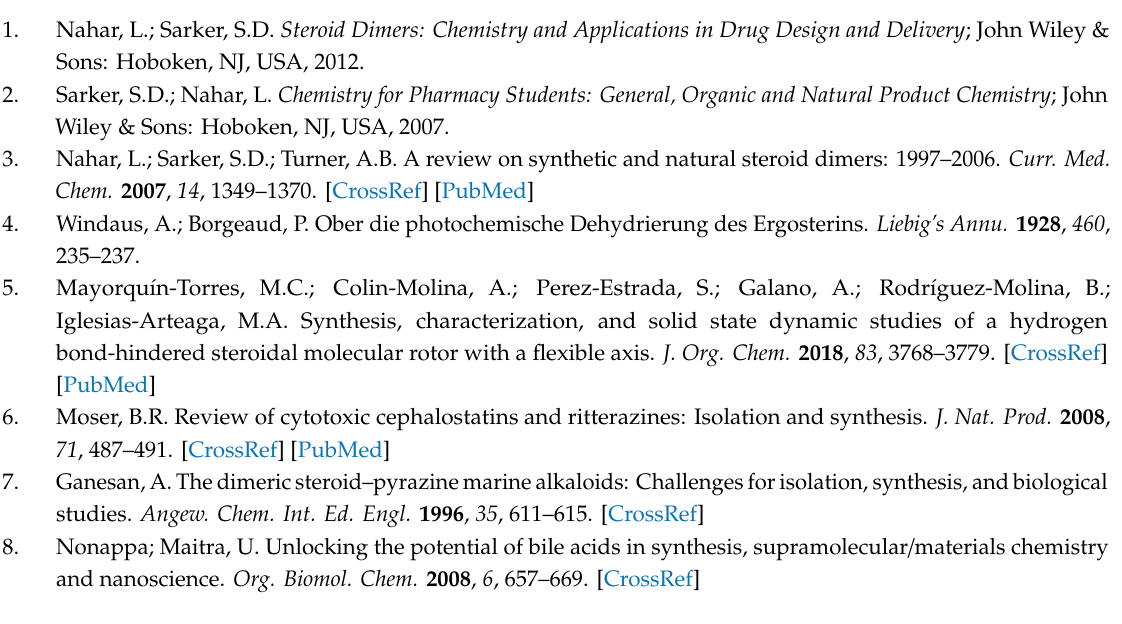
Figure S31: HSQC-NMR spectrum at 500 MHz of Bi-23-acetylhecogenin ester (10b). Figure S32: COSY-NMR spectrum at 500 MHz of Bi-23-acetylhecogenin ester ( 10b ). Figure S33: Di ff erential Scanning Calorimetry analysis of Bi-23-acetylhecogenin ester ( 10b ). Figure S34: Molecular structure with MM2 energy minimization method for 6 and 8c . Figure S35: Bicholesterol ester ( 5 ) in hexane / EtOAc showing membrane-shaped structures (SEM). Figure S36: Bicholesterol ester ( 5 ) in hexane / EtOAc showing membrane-shaped structures (SEM). Figure S37: Bicholesterol ester ( 5 ) EtOAc showing strand-shaped structures (SEM). Figure S38: Bidiosgenin ester ( 8a ) in EtOAc showing strand-shaped structures (SEM). Figure S39: Bidiosgenin ester ( 8a ) in CHCl 3 / MeOH (SEM). Figure S40: Bidiosgenin ester ( 8a ) in CHCl 3 / MeOH (SEM). Figure S41: Bisarsasapogenin ester ( 8c ) in hexane / EtOAc showing membrane-shaped structures (SEM). Figure S42: Bi-23-acetyldiosgenin ester ( 10a ) in EtOAc showing strand-shaped structures (SEM). Figure S43: Bi-23-acetyldiosgenin ester ( 10a ) in EtOAc showing strand-shaped structures (SEM). Figure S44: Bi-23-acetyldiosgenin ester ( 10a ) in EtOAc showing strand-shaped structures (SEM). Figure S45: Bi-23-acetylhecogenin ester ( 10a ) in EtOAc showing strand-shaped structures (SEM). Figure S46: Bi-23-acetylhecogenin ester ( 10a ) in EtOAc showing strand-shaped structures (SEM). Figure S47: Powder X-ray di ff raction patterns for raw materials of steroidal dimers 5 , 6 , 8c , 10a and 10b . Patterns were collected with the Cu-K α radiation, and are uncorrected for amorphous contribution. Figure S48: Comparison of the X-ray di ff raction patterns of Bidiosgenin ester ( 8a ) under di ff erent conditions: raw material, layered material, dimer in contact with chloroform-methanol, and with hexane-ethyl acetate. Patterns were collected with the Cu-K α radiation, and are uncorrected for amorphous contribution. Note the intensity variation for the peak at 2 θ = 11.5 ◦ , as a consequence of the self-organization of the steroidal dimer. CIF file of Bi-23-acetyldiosgenin ( 10a ). Video: Bicholesterol ester in Hexane / EtOAc system